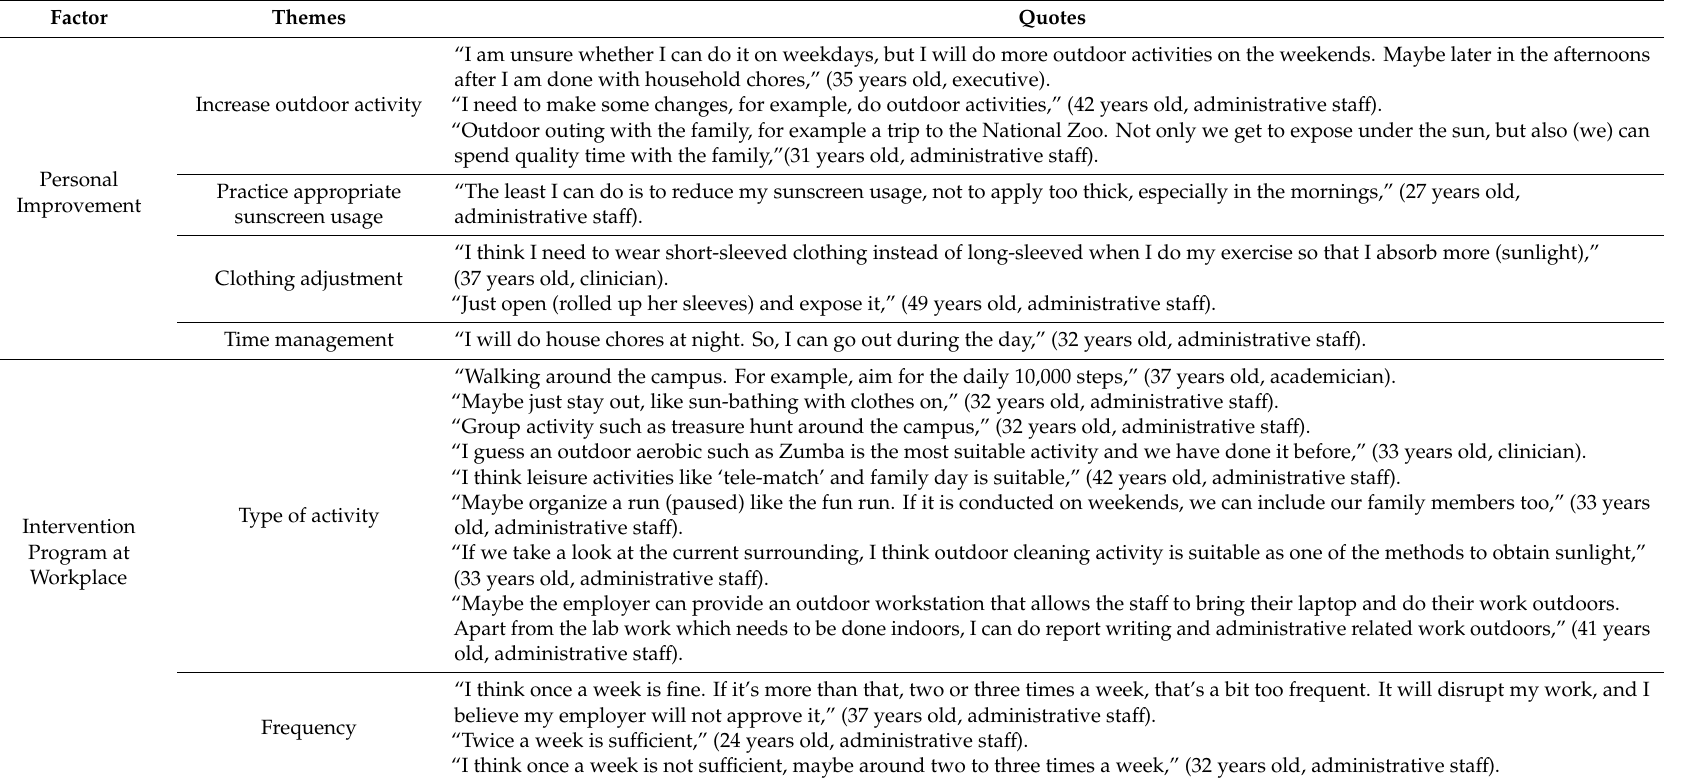
Table 4. Themes for strategies to overcome the